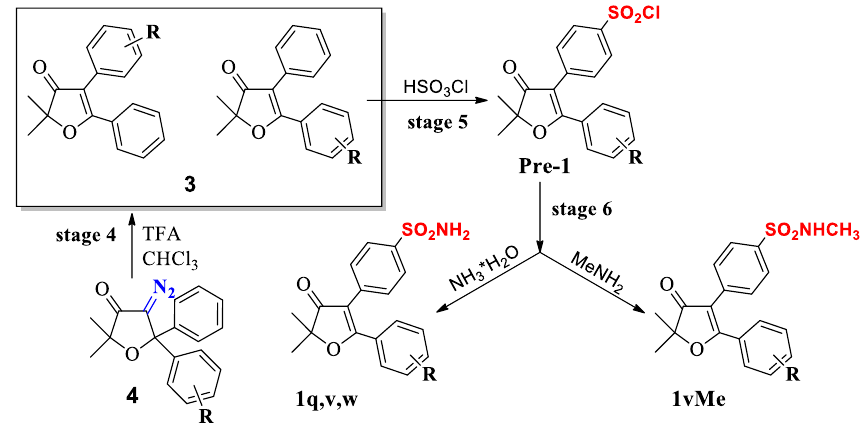
a The yield in brackets is given taking into account incomplete conversion of benzophenone. b The